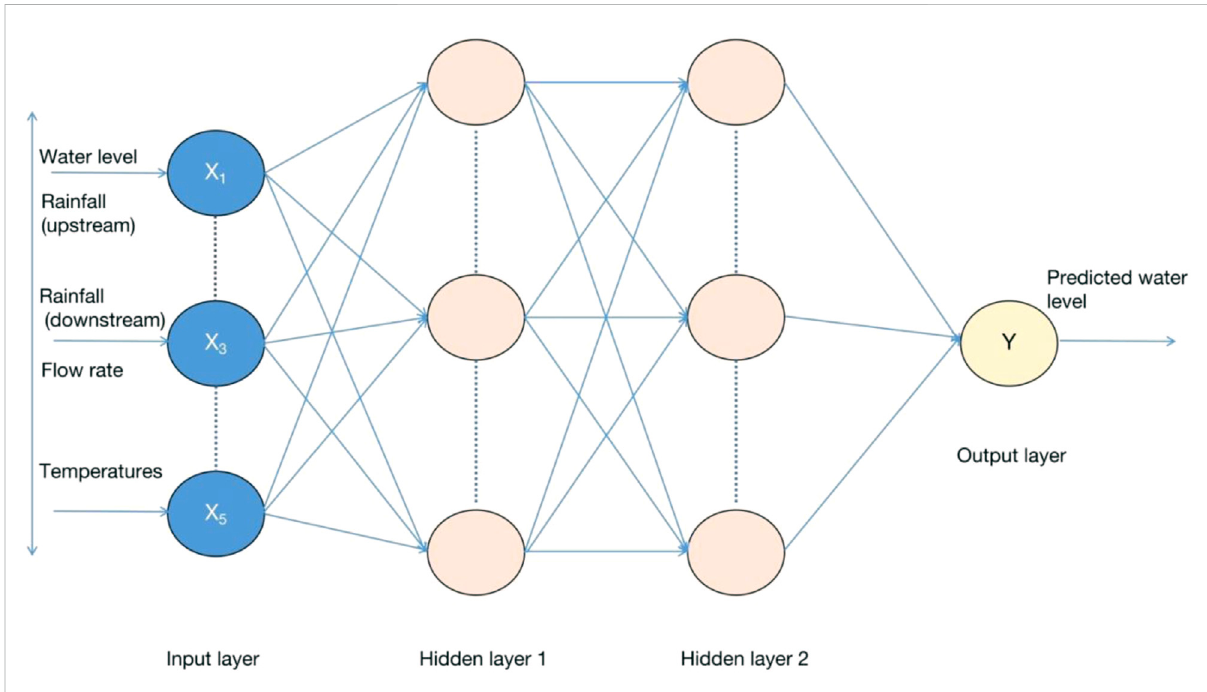
FIGURE 2 Network architecture of Multilayer Perceptron Neural Network (MLP-NN) for this